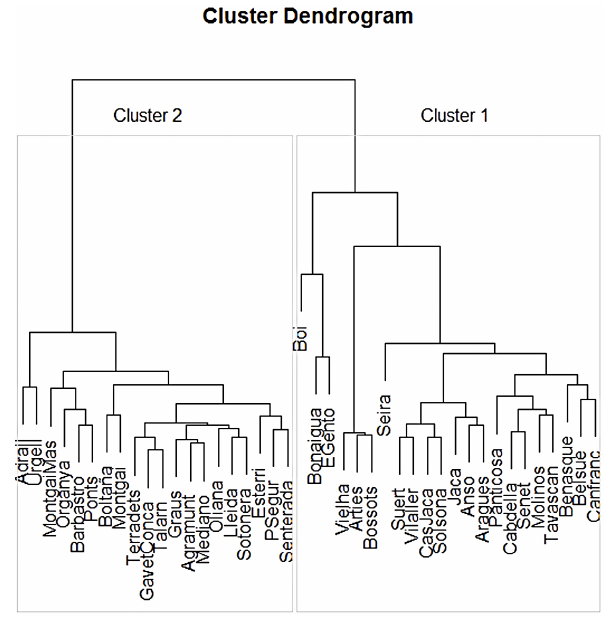
Figure 3. Result of the hierarchical cluster analysis on the first step of computation (see Sect.